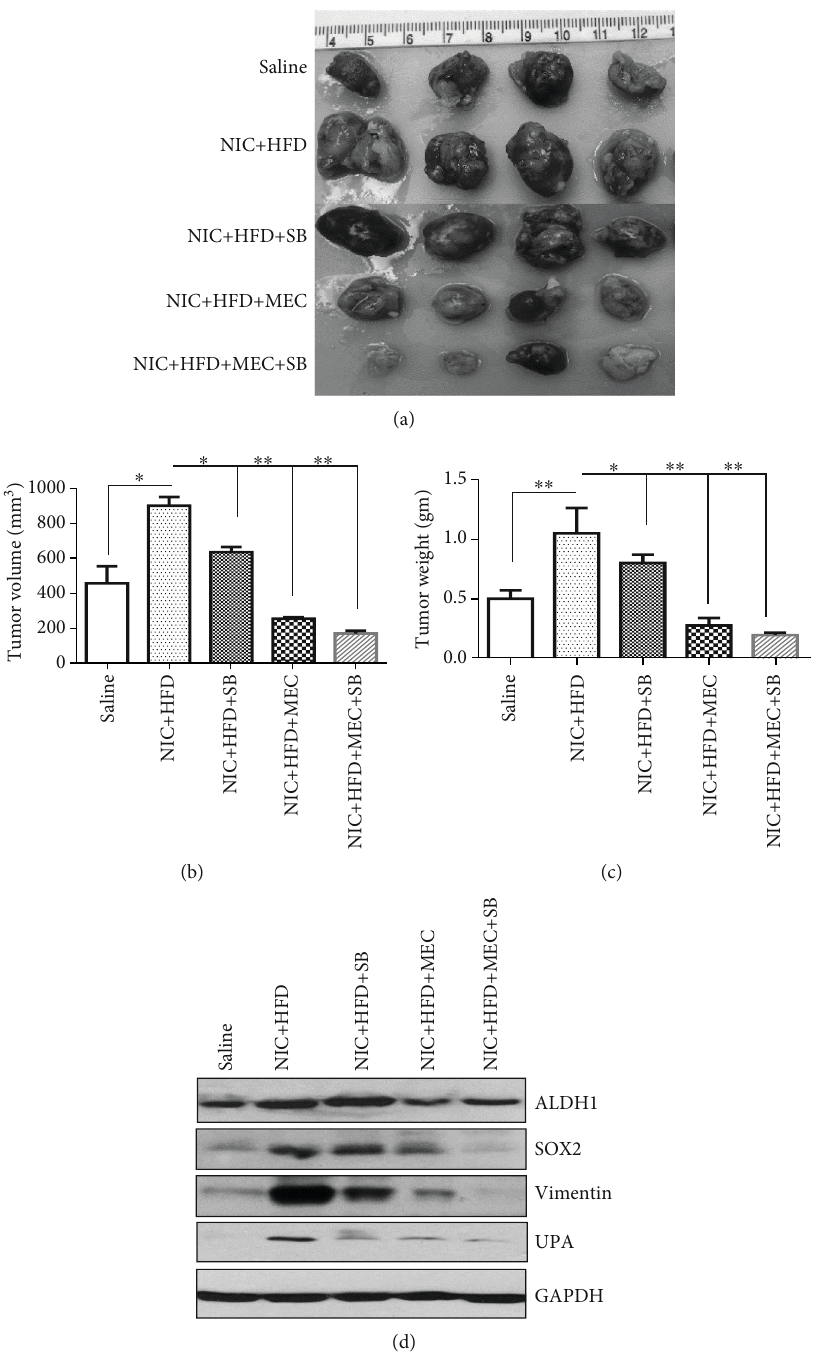
Figure 6: E ff ect of MEC and pp38MAPK inhibitor SB203580 on tumor growth in NIC and HFD-treated nude mice: HCC70 breast cancer cells (2 × 10 6 cell/mice) were implanted in nude mice prefed on HFD (2 weeks) and exposed to NIC (intraperitoneal injection twice/day for 2 weeks, 0.75mg/kg/mice/injection). Xenografts were grown in mice continued on either HFD ± NIC treatment (0.75 mg/kg/mice/injection twice a day) along with treatment with MEC (0.8 mg/kg/mice/injection, twice a day) with or without SB203580 (0.2 μ mols in 100 μ l/mice once/day/every day) till the tumors were excised. (a) Representative picture of xenografts after various treatments is shown. (b) Analysis of tumor volume following various treatments over a period of 8 weeks. (c) Analysis of tumor weight following various treatments over a period of 8 weeks. (d) Immunoblot analysis of ALDH1, SOX2, vimentin, and UPA in pooled tumors from various treatment groups ( n = 5 ). ∗ p ≤ 0 : 05 and ∗∗ p ≤ 0 : 01